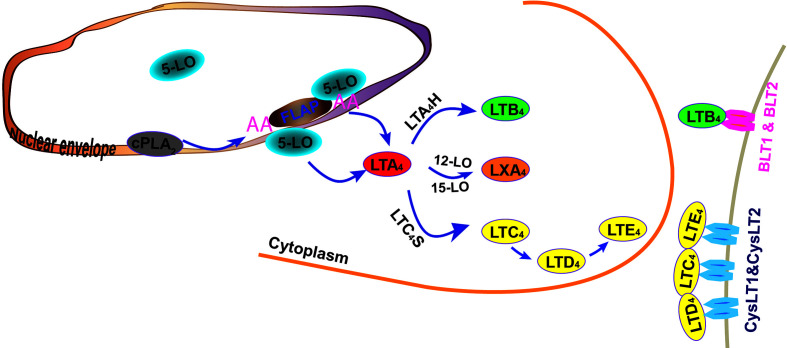
Biosynthesis of leukotrienes. Arachidonic acid (AA) is first generated by cytoplasmic phospholipase A2 (cPLA2) and converted into leukotriene A4 (LTA4) through the cooperative actions of 5-lipoxygenase (5-LO) and 5-LO–activating protein (FLAP). From the inner nuclear membrane, AA is metabolized into LTA4 by inner nuclear membrane-localized 5-LO and is further converted into LTB4 by LTA4 hydrolase (LTA4H). AA is also metabolized to LTA4 by 5-LO located on the outer nuclear membrane and converted to LTC4. LTC4S (LTC4 synthase) conjugates LTA4 with glutathione to form LTC4 and its metabolites, LTD4 and LTE4. (LTA4 may also be metabolized into lipoxin A4 [LXA4] by 12-LO or 15-LO.) Leukotrienes signal through two sets of G-protein coupled receptors, which are receptors for LTB4 (BLT1 and BLT2) and receptors for LTC4, LTD4, and LTE4 (CysLT1 and CysLT2).